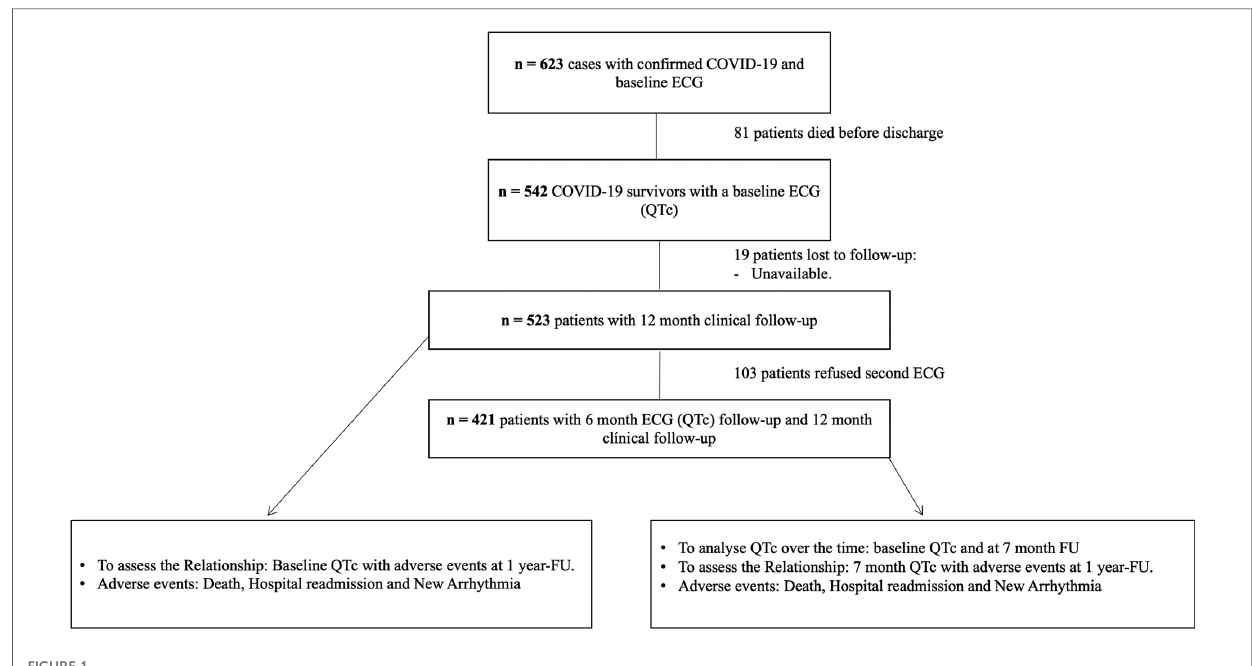
FIGURE 1 Flowchart of patient